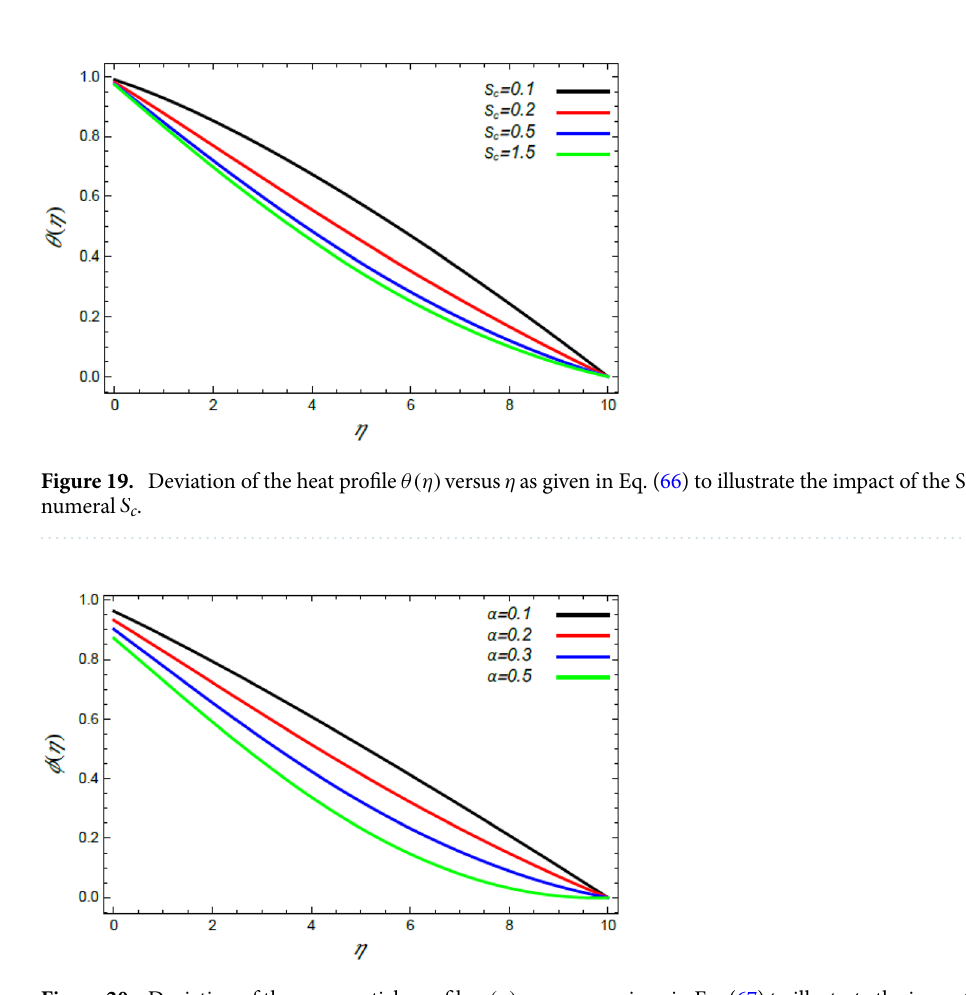
Figure 20. Deviation of the nanoparticle profile ϕ(η) versus η as given in Eq. (67) to illustrate the impact of the stretching factor α